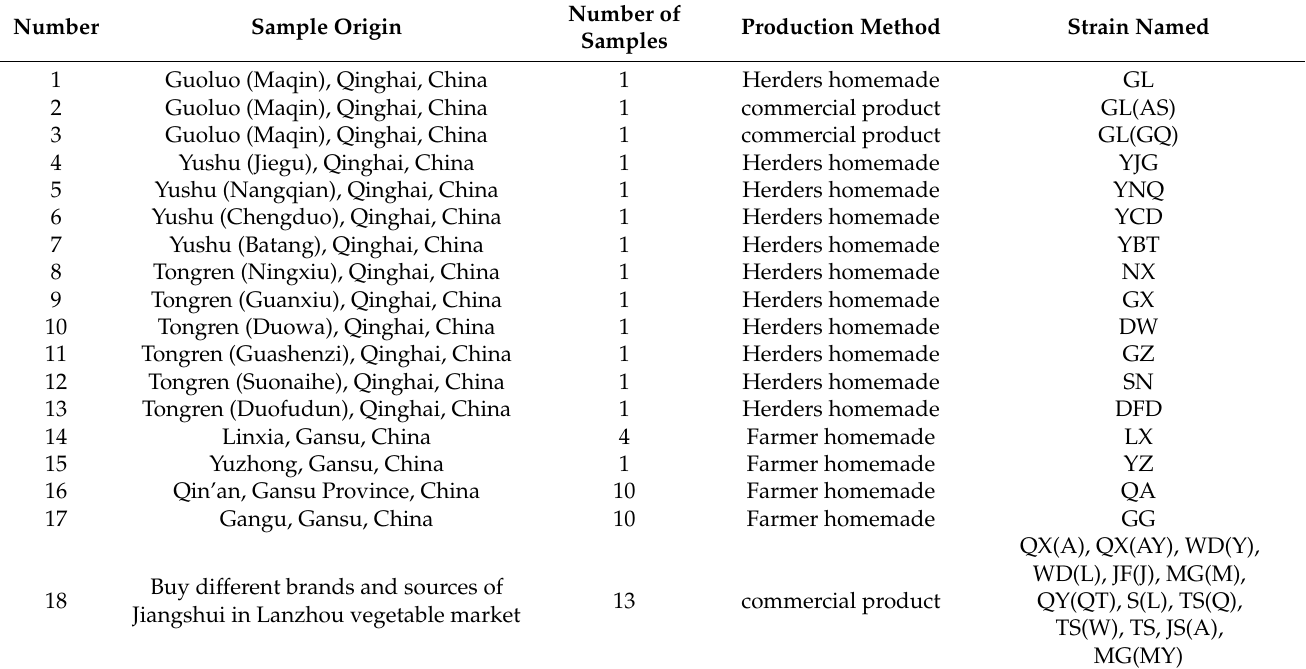
Table 1. Fermented food sample